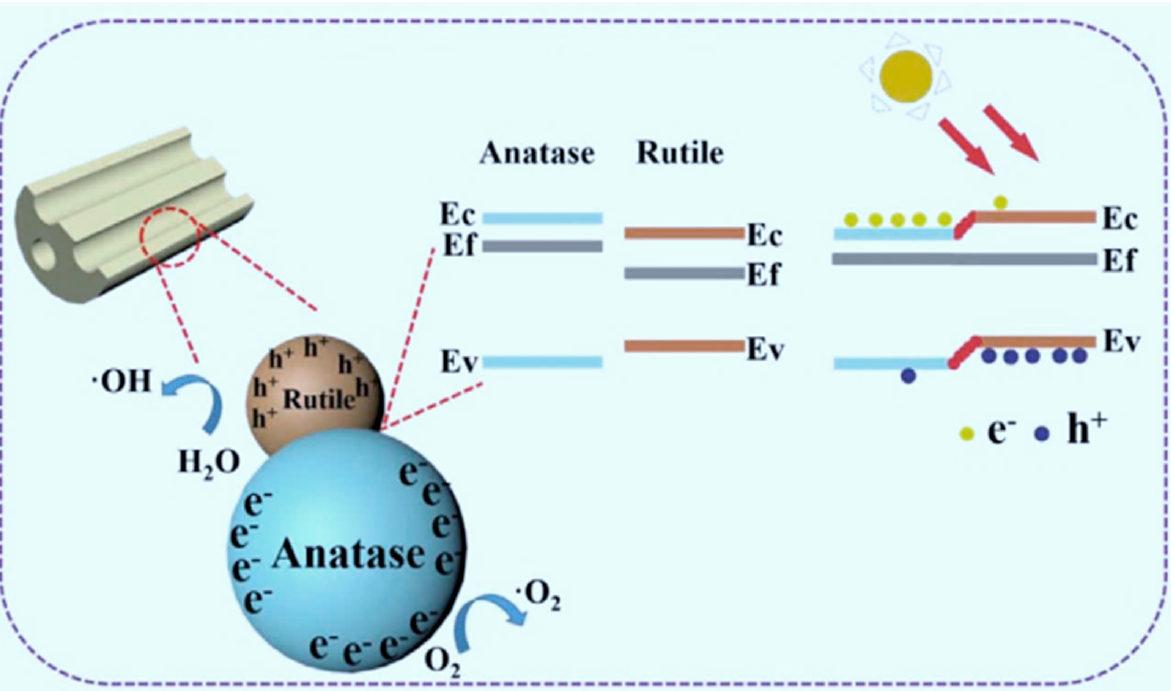
Figure 6. The mechanism of improved photocatalytic performances for hierarchical TiO 2 nanofibers [105].